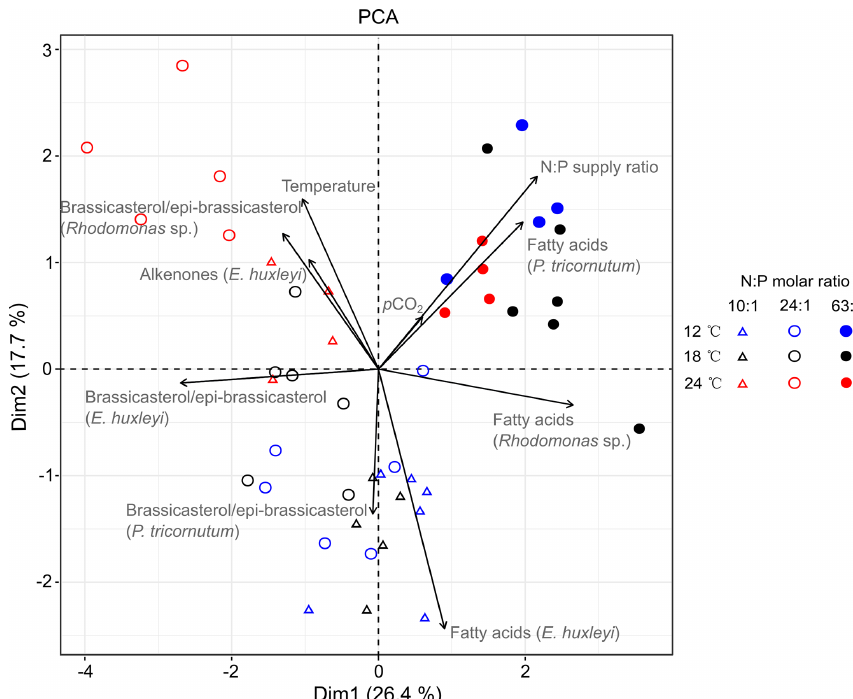
Figure 3. PCA biplot based on the carbon-normalized contents of the major sterol (brassicasterol / epi-brassicasterol) and total fatty acids (µgmgC − 1 ) in Phaeodactylum tricornutum , Rhodomonas sp. and Emiliania huxleyi , as well as C 37 –C 39 total alkenones in E. huxleyi under different temperatures, N:P supply ratios and p CO 2 . Blue, black and red symbols represent 12, 18 and 24 ◦ C, respectively. Open triangles, open circles and closed circles represent N:P molar ratios of 10:1, 24:1 and 63:1, respectively. The first two dimensions (Dim1 and Dim2) account for 44.1% of the total variance. The length of each vector reflects the combined loading of each variable in the first two dimensions (Table